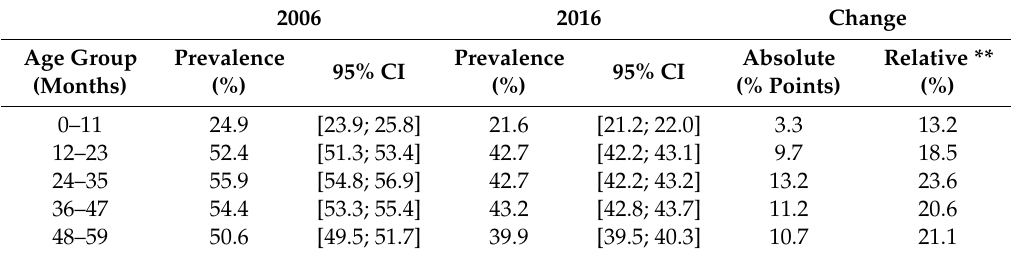
Table 1. Prevalence of child stunting by age groups, India, NFHS 2006, and